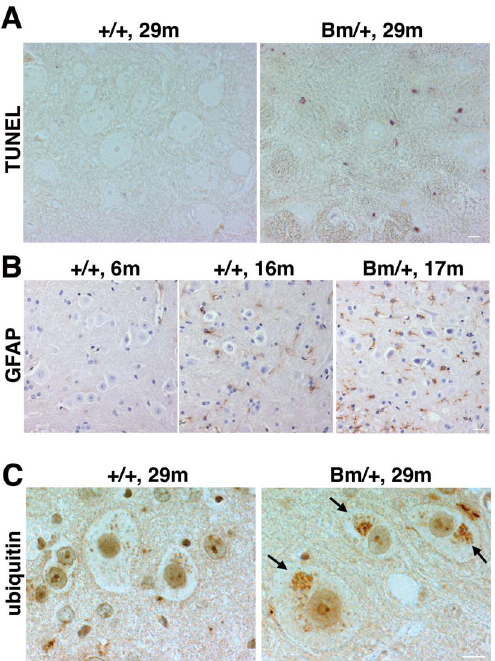
Figure 3. Some motoneurons in the spinal cord revealed a degeneration accompanied by accumulations of ubiquitinated proteins. (A) TUNEL staining revealed some apoptotic cells at the anterior horn in the spinal cord of a 29 month-old mutant BiP mouse (Bm/ + , 29 m). Scale bars, 10 um. (B) The immunoreactivity with an anti- GFAP antibody at the anterior horn is increased in a 17 month-old mutant spinal cord (Bm/ + , 17 m). Scale bars, 20 um. GFAP positive cells are counted (five fields in each mouse, GFAP positive cells/the number of nucleus). + / + , 16 m; 33/199, 35/174, 34/192, 40/181, 42/207, Bm/ + , 17 m; 42/132, 50/140, 59/147, 39/154, 58/143 + / + , 6 m; 5/143, 4/131, 4/ 141, 0/95, 0/107. The ratio of GFAP positive cells is significantly higher in the mutant BiP spinal cord (Bm/ + , 17 m) compared to that in the wild type ( + / + , 16 m) by t test (p value is 0.0009). (C) The aggregations were stained by an anti-ubiquitin antibody in the large cells at the anterior horn of the 29 month-old mutant spinal cord (Bm/ + , 29 m, arrowheads). Scale bars, 10 um.